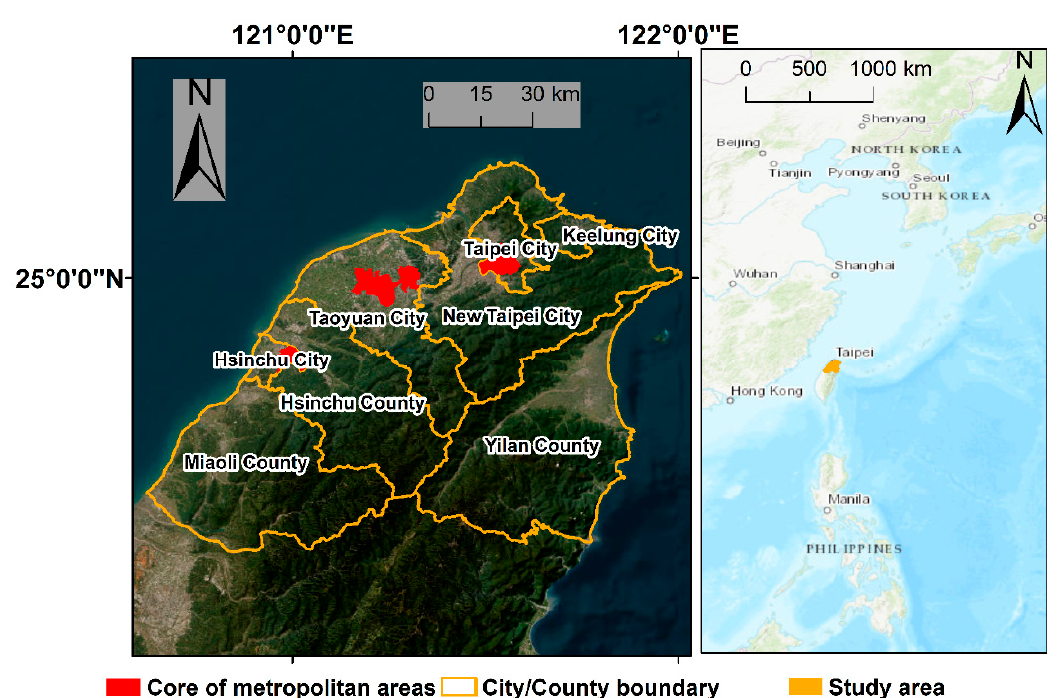
Figure 1. Study area for north region of Taiwan along with the cores of metropolitan areas within the study area.